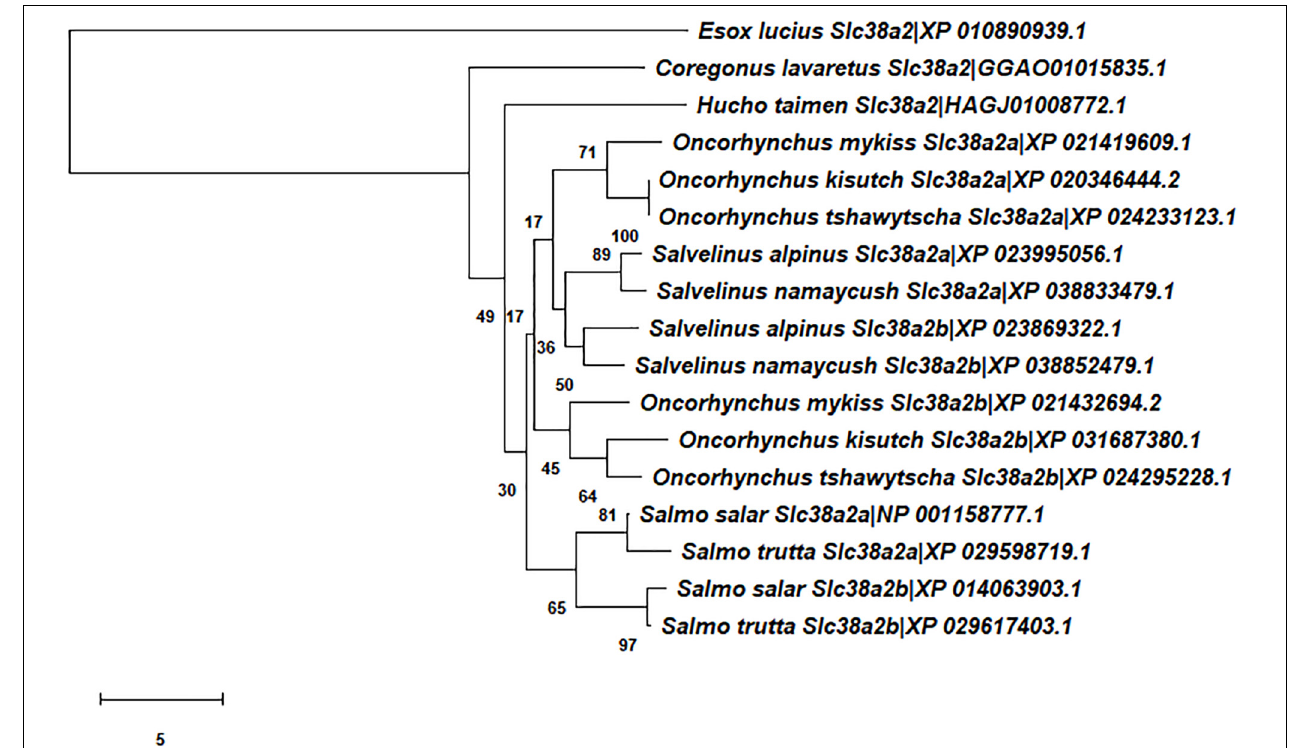
FIGURE 2 | Unrooted phylogenetic tree depicting the evolutionary relationships of Atlantic salmon Slc38a2-type transporters in the context of the evolutionary relationships of Salmoniformes and Esociformes. See legend of Figure 1 for further